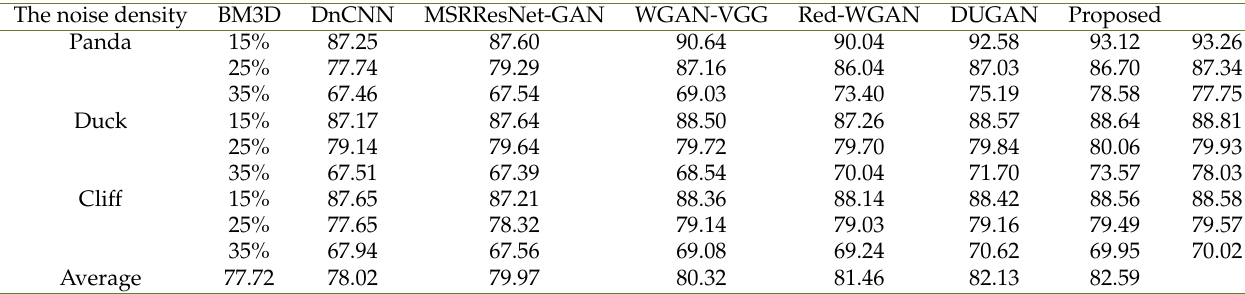
Table 2. SSIM value for figure 5%